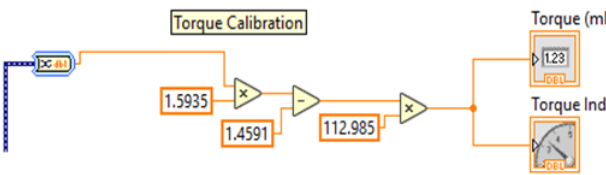
Figure 11. Implementing the torque sensor calibration in LabVIEW.